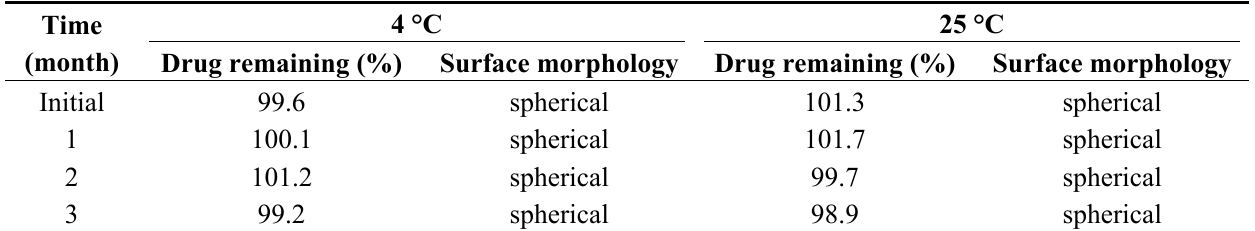
Table 1. Stability data of DTX-loaded microspheres over three